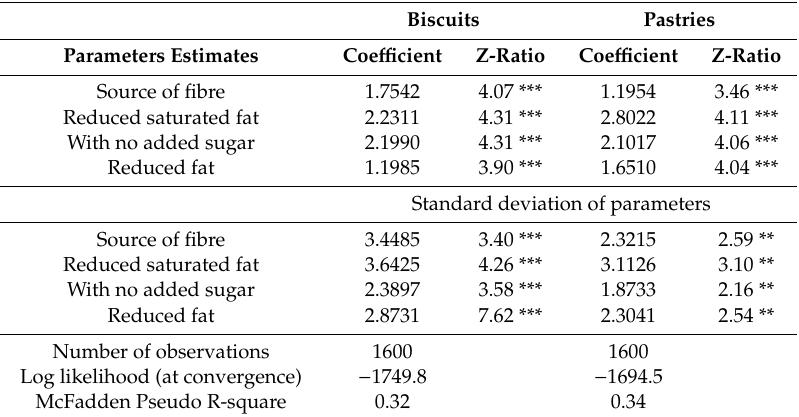
Table 6. Estimation results of the rank-ordered mixed